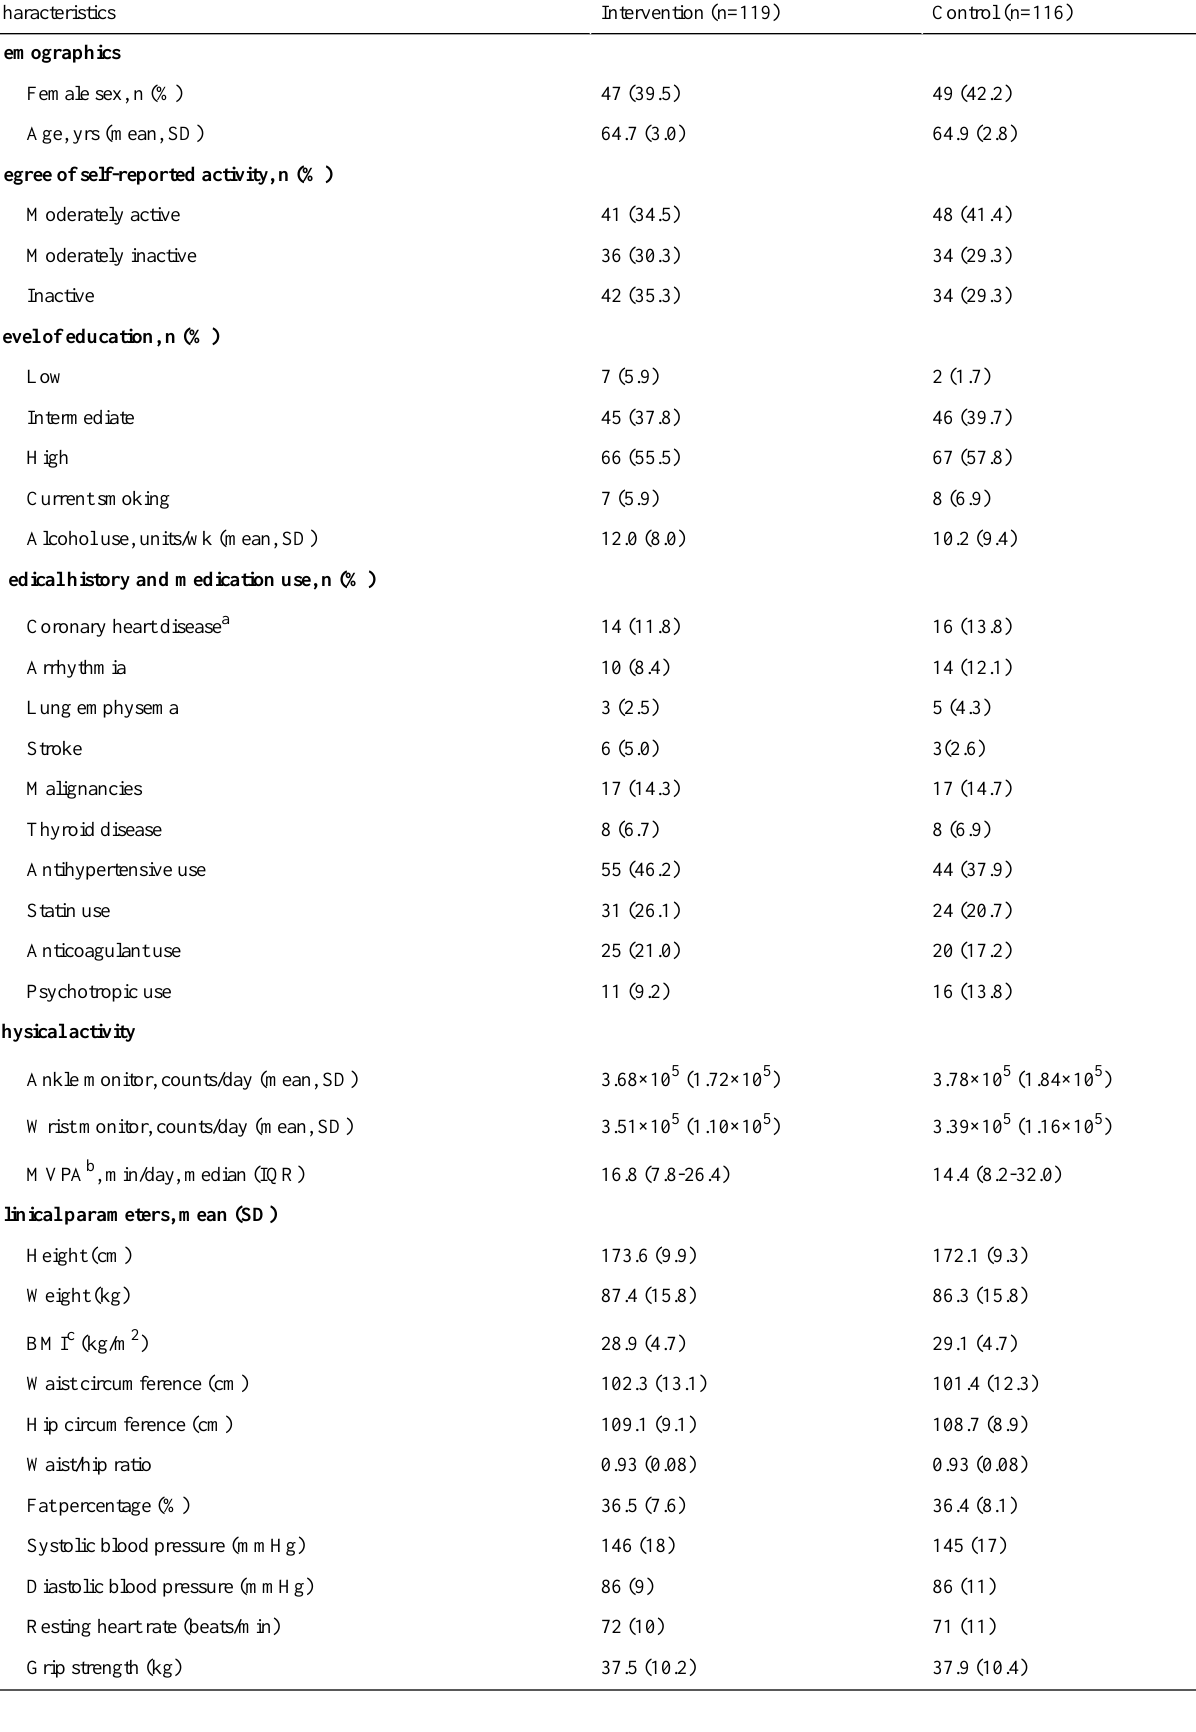
Table 1. Baseline characteristics of study participants (data are presented as medians with interquartile range [IQR] when skewed; alcohol use was calculated only in those who reported drinking alcohol [n=102 for intervention and n=101 for